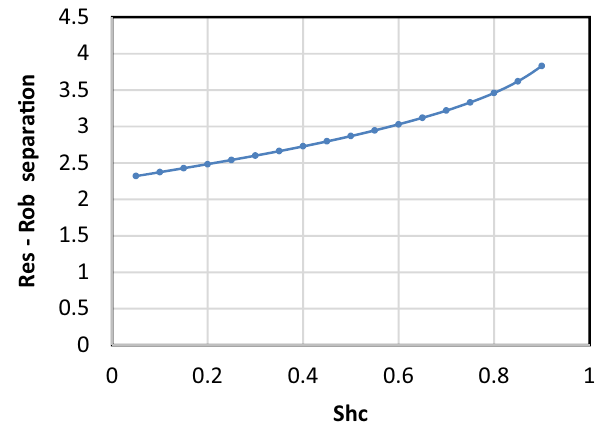
Fig. 22 S hc versus separation for